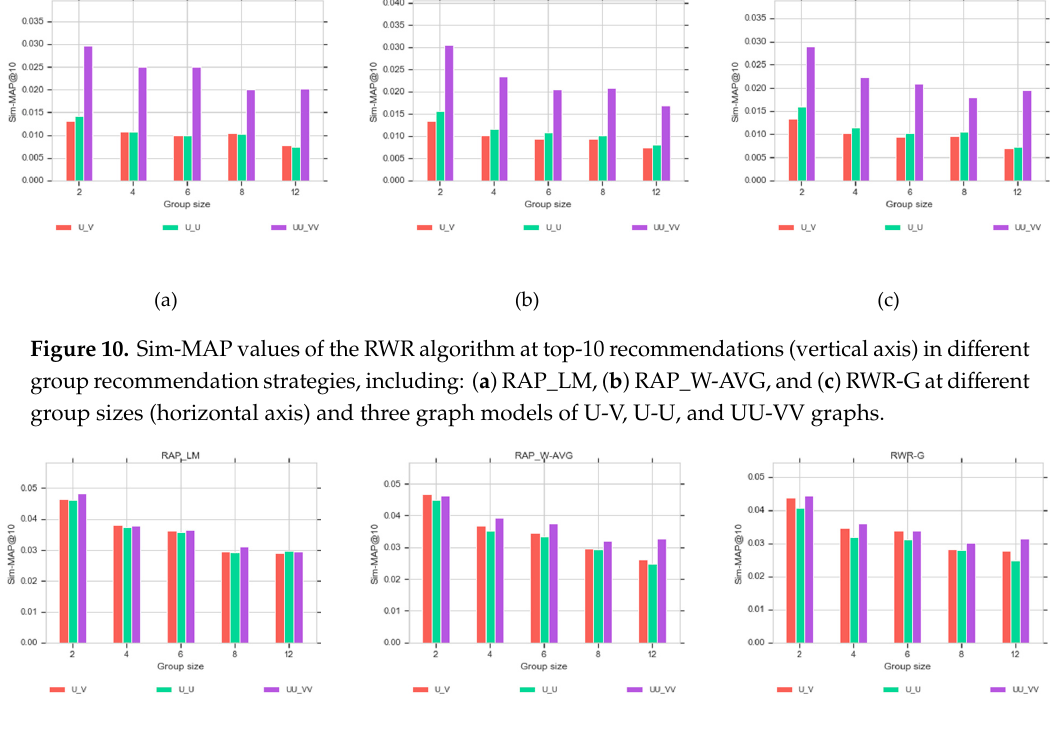
Figure 9. HR values of CLGRW at top-10 recommendations (vertical axis) in different group recommendation strategies, including RAP_LM, RAP_W-AVG, and RWR-G at different group sizes (horizontal axis) and three graph models: ( a ) U-V graph; ( b ) U-U graph, and ( c ) UU-VV graph.